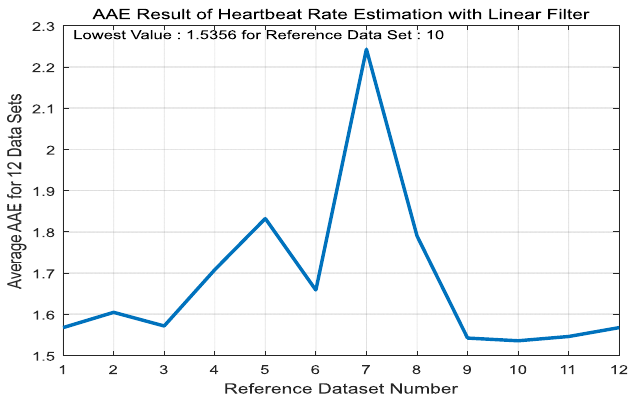
Figure 5. Average AAE’s of the linear filters in Table 3 over the total datasets for LOOCV application.